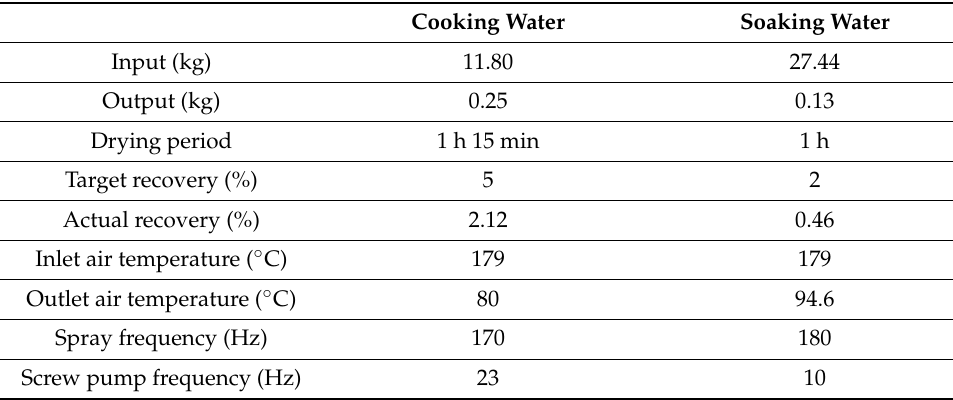
Table A1. Spray-drying parameters of split yellow pea